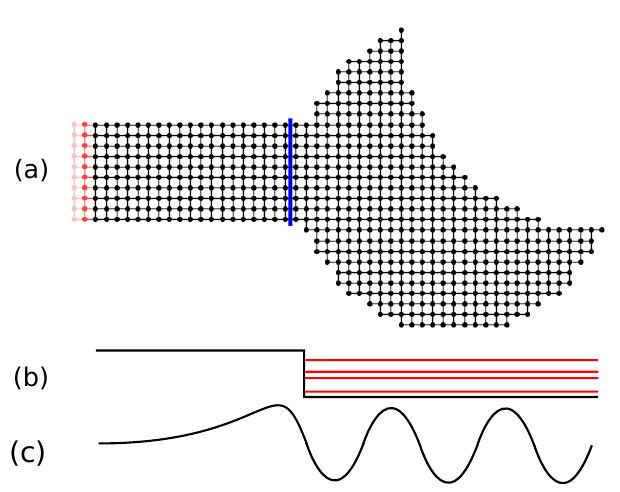
Figure 1: Panel (a): an example system considered in this work consisting of a scattering region (right of the blue line) connected to a semi-infinite lead (on the left, the red cells are to be repeated up to infinity). (b): The energy spectrum shows several discrete levels next to the continuous spectrum of the bands. (c): A schematic representation of a bound state wavefunction, decaying exponentially fast in the